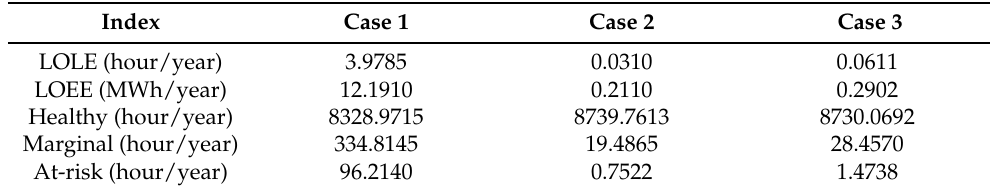
Table 2. Reliability